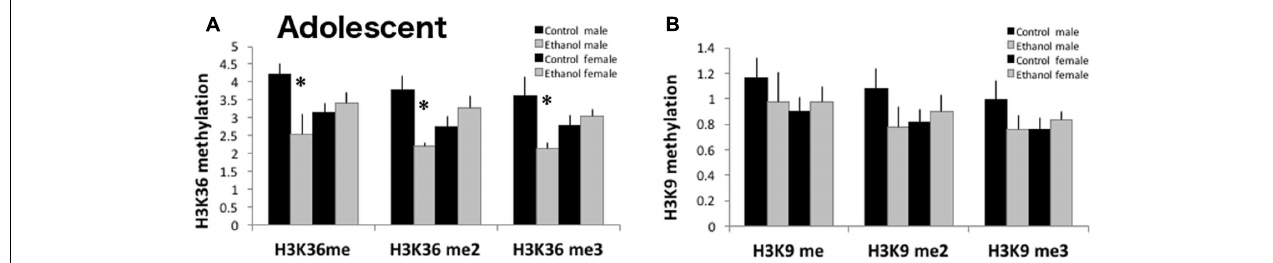
FIGURE 7 | H3K36 methylation is decreased in ethanol exposed adolescent males. (A) Using ELISAs to measure global methylation in PFC ( n = 3–4/group), binge ethanol decreased H3K36me, H3K36me2 and H3K36me3 in DBA males ( ∗ p < 0.05, interaction between treatment and sex by Two-Way ANOVA). (B) H3K9 methylation (mono- di- or tri-) was not significantly altered by binge ethanol ( n = 3–4/group). Data is presented as mean +/–